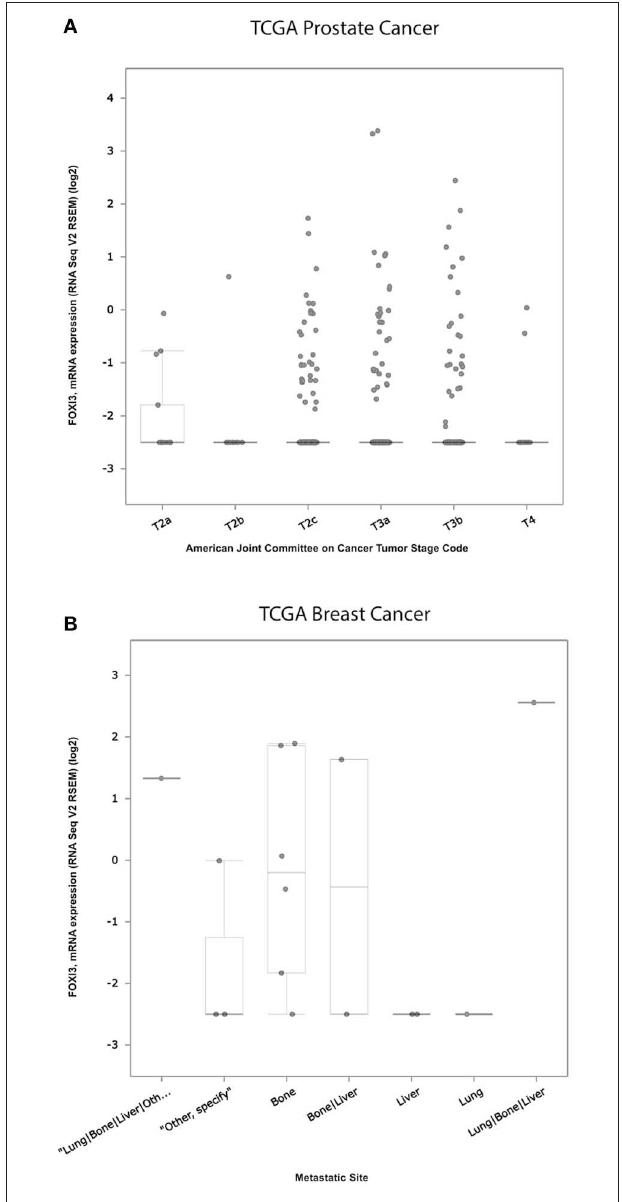
FIGURE 3 | Expression of FOXI3 in prostate and breast cancers. (A) RSEM normalized expression values of the TCGA prostate cancer cohort with tumor stage (Cancer Genome Atlas Research Network, 2015). (B) RSEM normalized expression values for TCGA breast tumors annotated according to site of distant metastasis (Anders and Carey, 2008). Both panels: Data was interrogated using cBioPortal